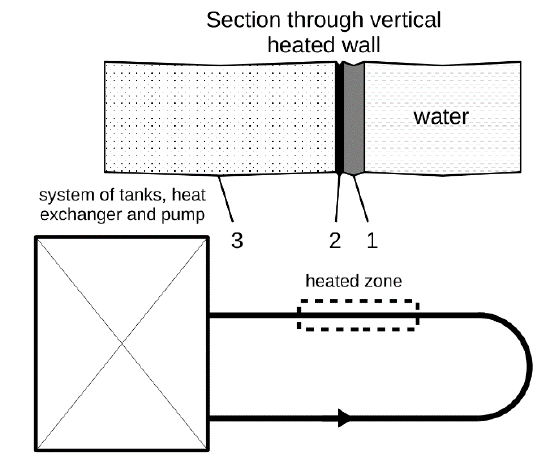
Fig. 4. Scheme of the water circuit by Koffi et al. 1 copper sheet, 2 strip electrical resistor, 3 thermal insulation..